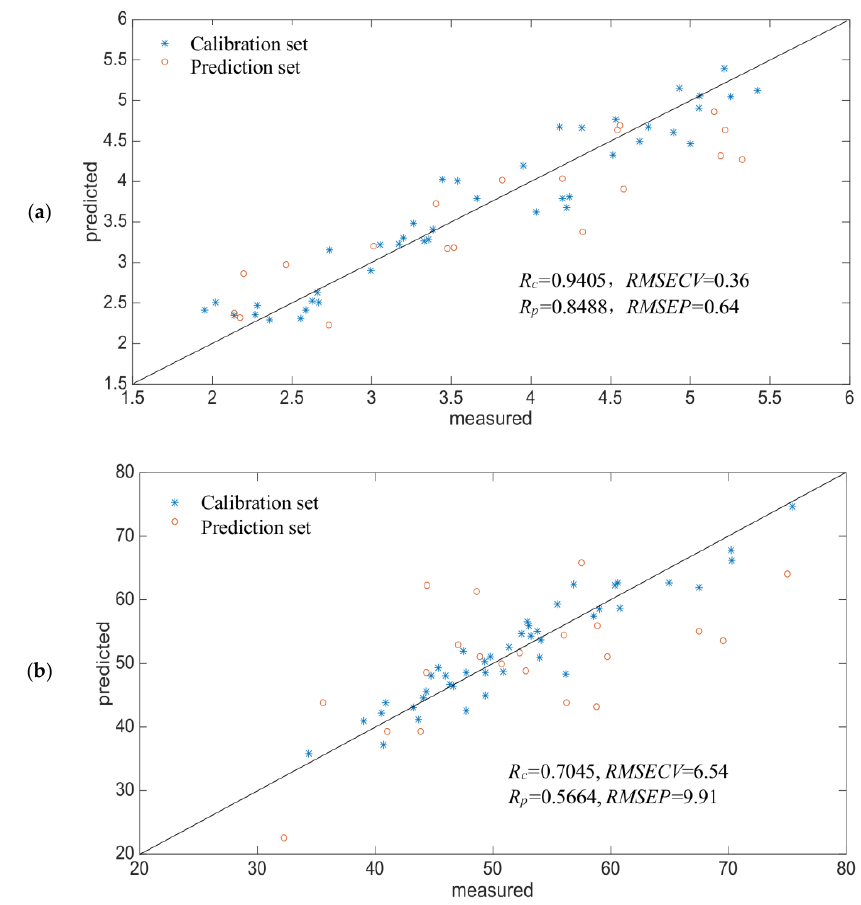
Figure 3. Reference measured versus NIR predicted value of Si-PLS model ( a ) SH content ( b ) SS content.